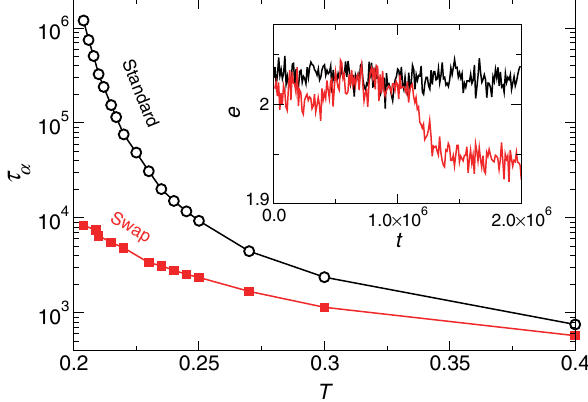
FIG. 5. Relaxation times τ α of standard (black empty points) and swap (red solid squares) simulations for the binary mixture of soft repulsive spheres studied in Sec. III A. The speedup offered by the swap moves is obvious, but the system is unstable below T ¼ 0 . 202 where it crystallizes, and temperatures below the ¼ 0 . 199 cannot be studied. mode-coupling temperature T MCT The inset shows a time series of the potential energy for standard (black) and swap (red) simulations at T ¼ 0 . 2 , and we see that crystallization is easily observed when swap moves are